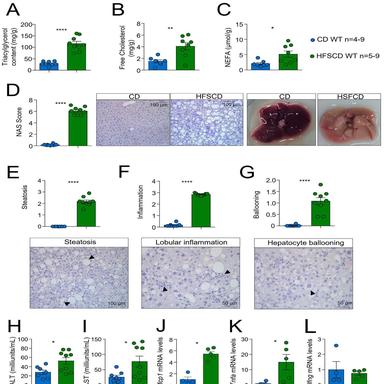
WT feeding for 16 weeks with a HFSCD produced hepatic steatosis and liver damage. Intrahepatic (A) triacylglycerol, (B) free cholesterol and (C) NEFA content in both WT mice fed CD and HFSCD. (D) NAS score calculated with the parameters of (E) steatosis, (F) lobular inflammation and (G) hepatocyte ballooning determined in hepatic cross-sections. Representative images hepatic cross-sections and whole liver for both mouse groups are shown next to the NAS score. Black arrows point to steatosis, lobular inflamm